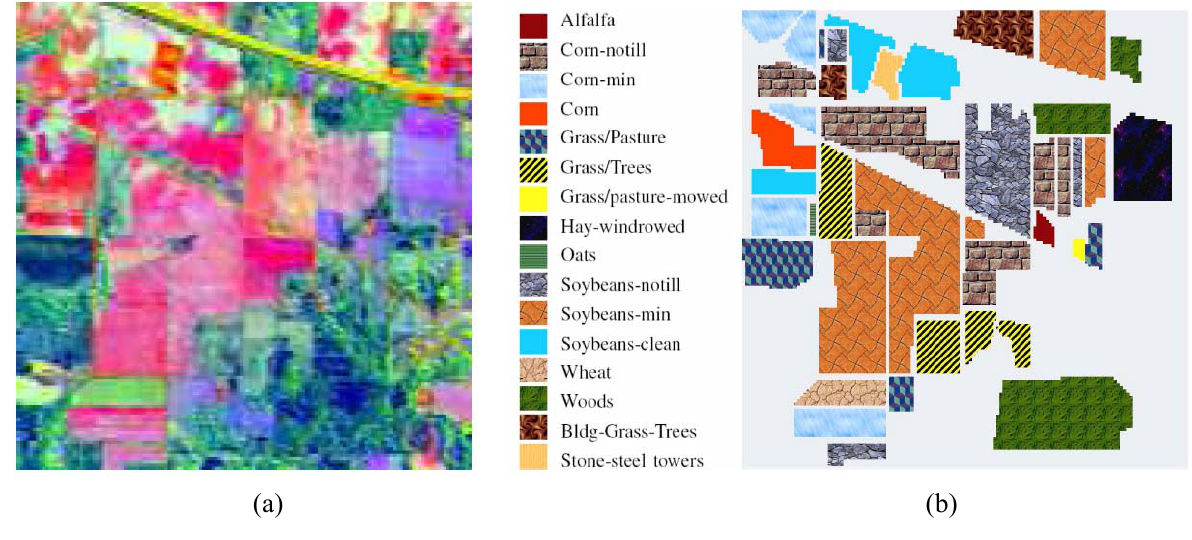
Figure 5. (a) False color composition of the AVIRIS Indian Pines scene. (b) Ground truth- map containing 16 mutually exclusive land-cover